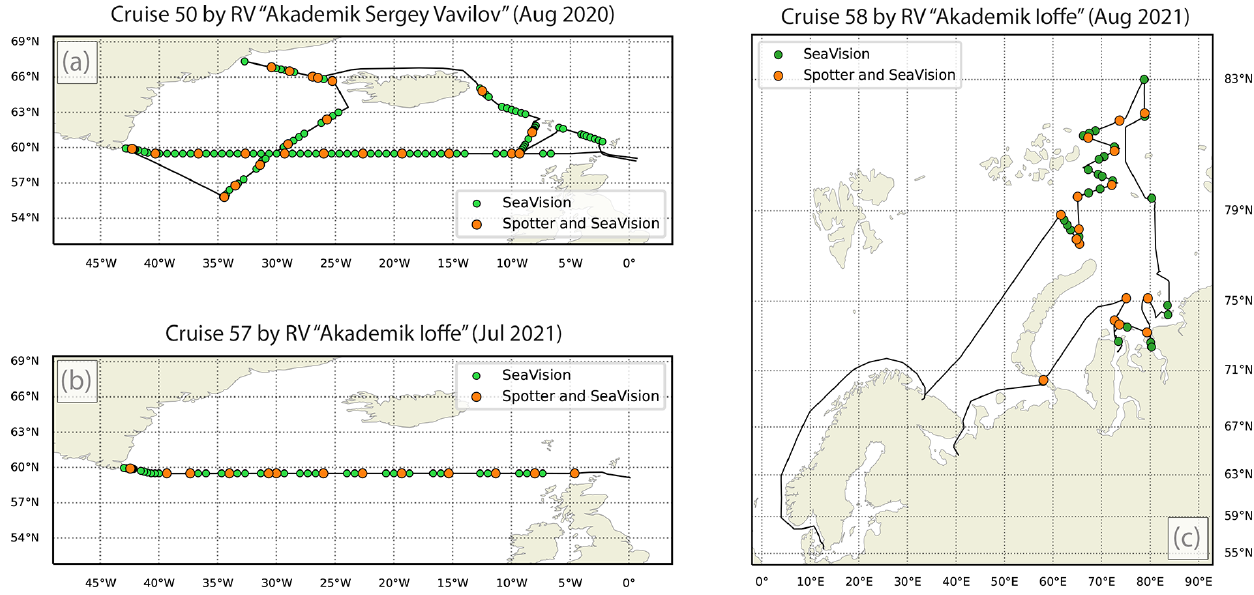
Figure 1. Ship tracks of the three cruises of the research vessels (R/Vs) Akademik Sergey Vavilov (a) and Akademik Ioffe (b, c) . Green dots indicate locations where only SeaVision radar data were collected, and orange dots show the locations for which SeaVision records were co-located with Spotter wave buoy measurements. Cruise numbers are counted from the beginning of the R/V operation. Table 1. Research cruises during which the wind wave observations were carried out by research vessels (R/Vs) Akademik Sergey Vavilov ( ASV ) and Academik Ioffe ( AI ). Adjacent numbers in the first column correspond to the R/V cruise numbers counted from the beginning of the R/V operation. Cruise Start date and location End date and location Distance sailed Number of